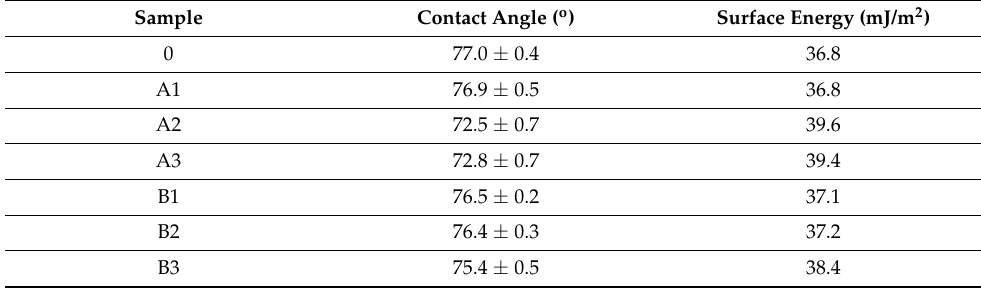
Table 4. Samples and raw materials used for the